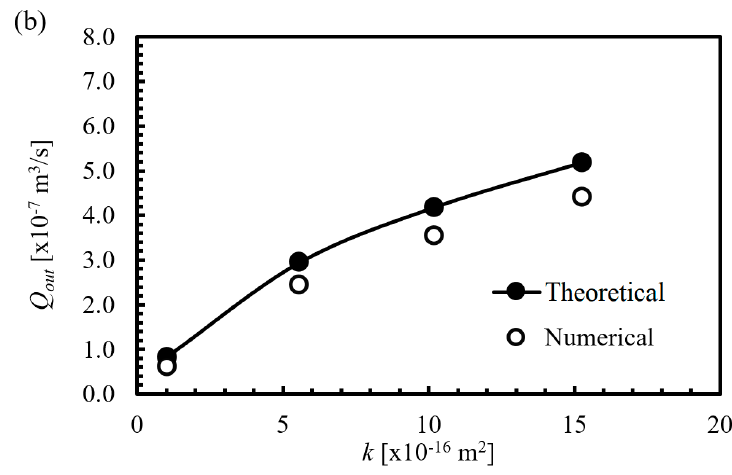
Figure 13. Comparison between the theoretical and numerical output flow rates for fibres with 0.4 mm inner diameter, 0.2 mm membrane thickness. ( a ) Single-end suction; ( b ) Double-end suction.